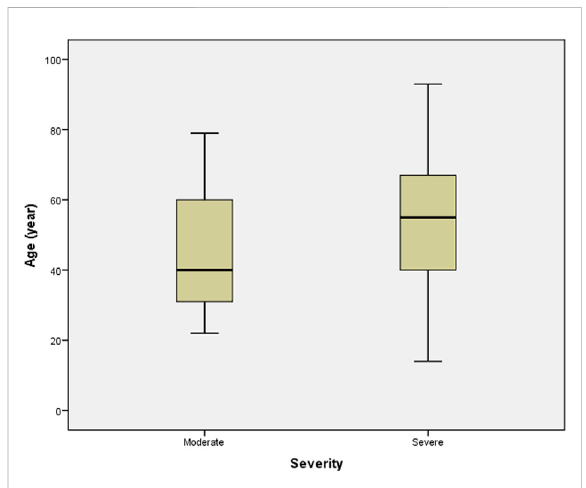
FIGURE 3 Distributionofthepatients ’ ageamongseverityofthedisease groups. Boxplots show the median and interquartile range, and whiskers represent the extreme cases of individual variables. The mean age of individuals in severe disease group was signi fi cantly higher than that ofin themoderate disease group ( p = 0.016).